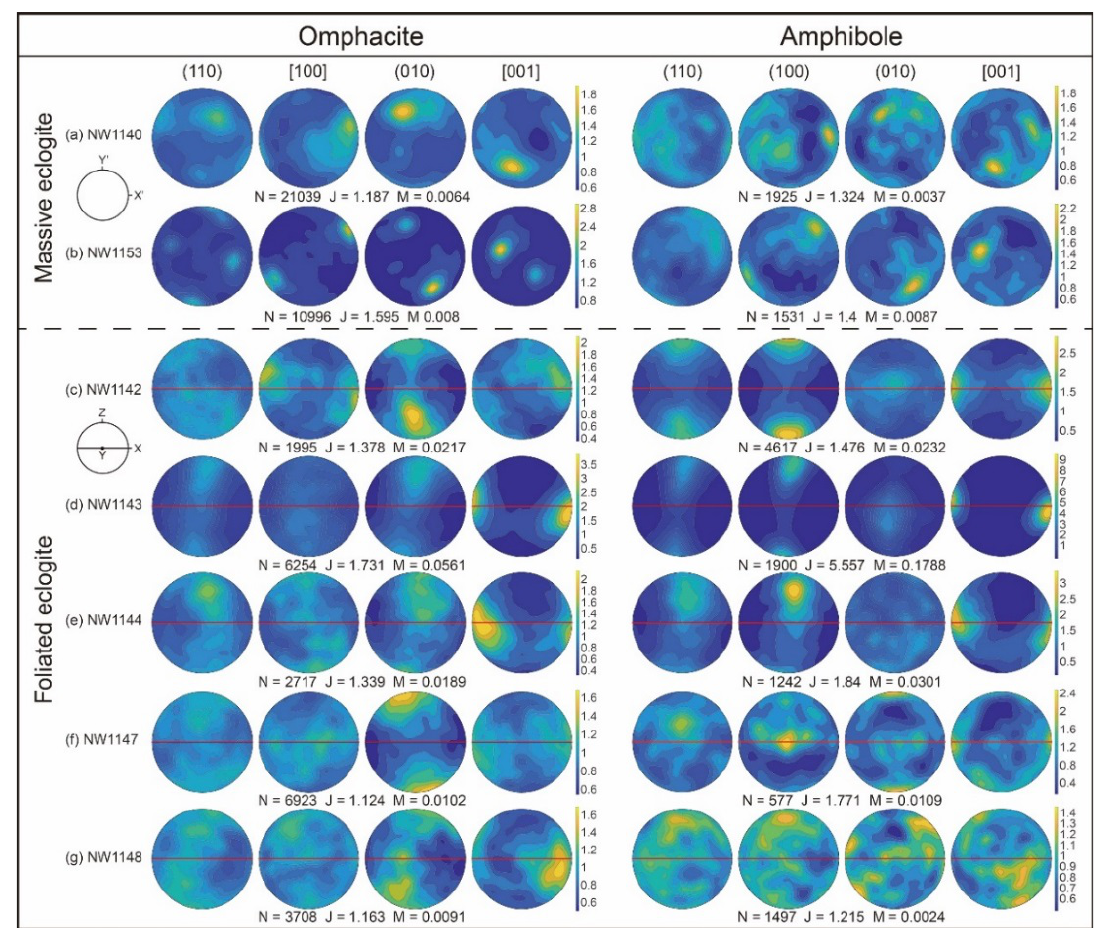
Figure 4. CPOs of the Omp (left column) and Amp (right column) in the MEC and FEC (modified from Cao et al. [42]). The method used to plot the pole figures and the associated parameters were the same as those used in Figure 3.